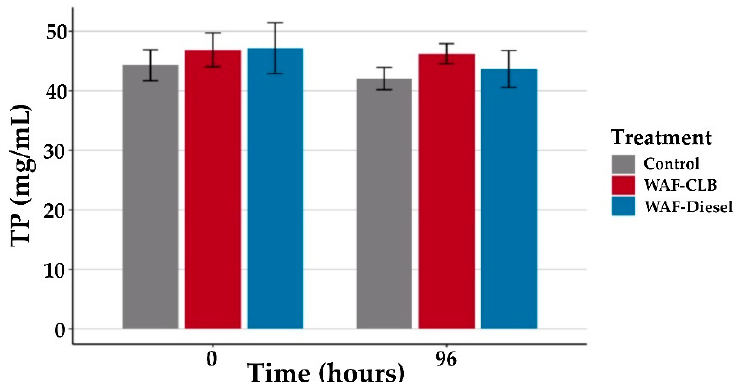
Figure 3. Total protein content (TP; mg/mL) in hemolymph, as calculated from measurements of the Brix index, of lobsters for each treatment (Control, WAF-CLB, and WAF-Diesel) before (0 h) and after 96 h of exposure. Series A and B are combined. Mean ± SE; n = 6.